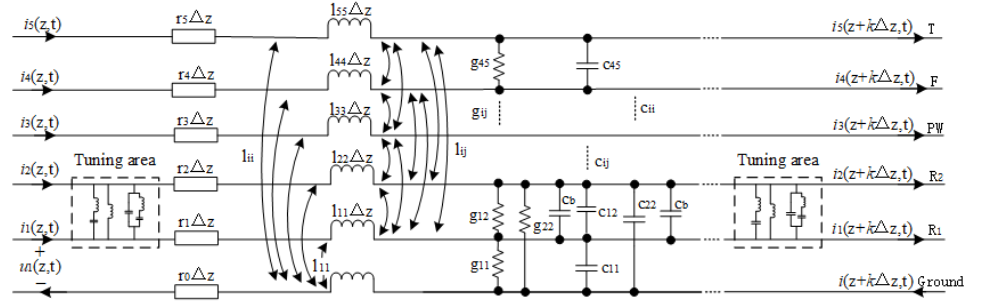
Fig. 1. Hybrid model of traction network and ZPW-2000A track circuit.